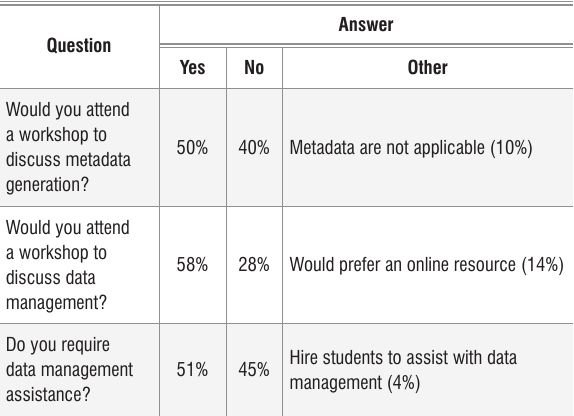
Potential for data management education as indicated